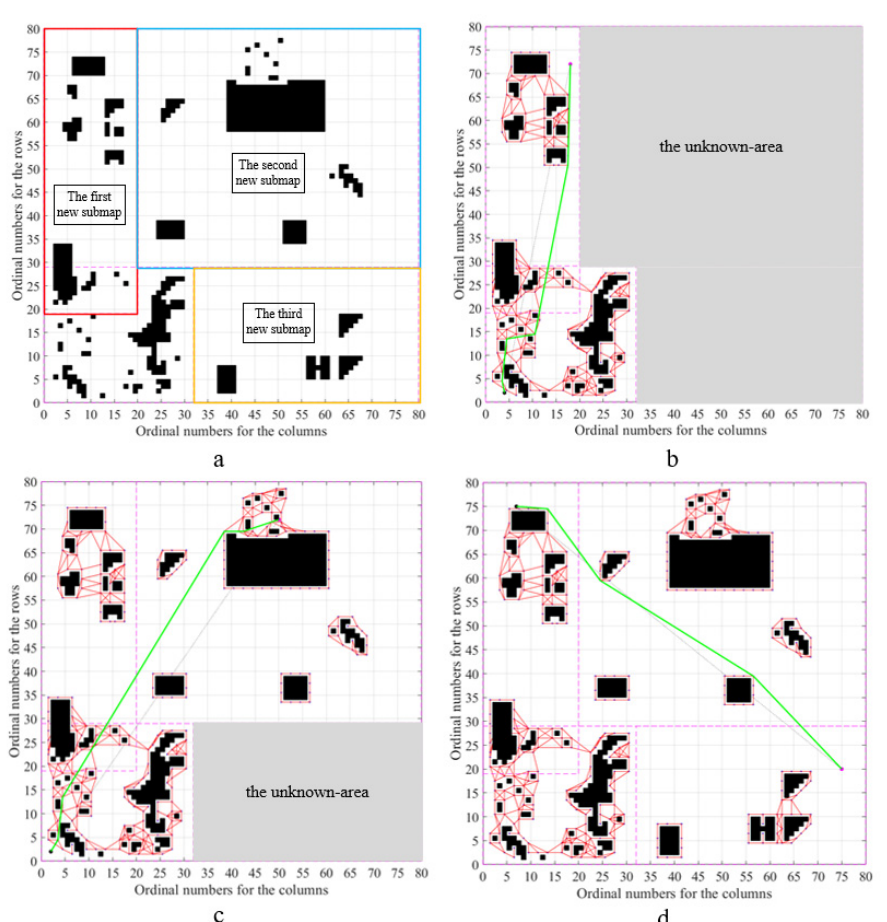
Figure 26. ( a ) Schematic of the map update. ( b ) Map after the first update. ( c ) Map after the second update. ( d ) After the third update. The red lines represent the roadmap and the green line is one of path planning results in ( b )–( d ).